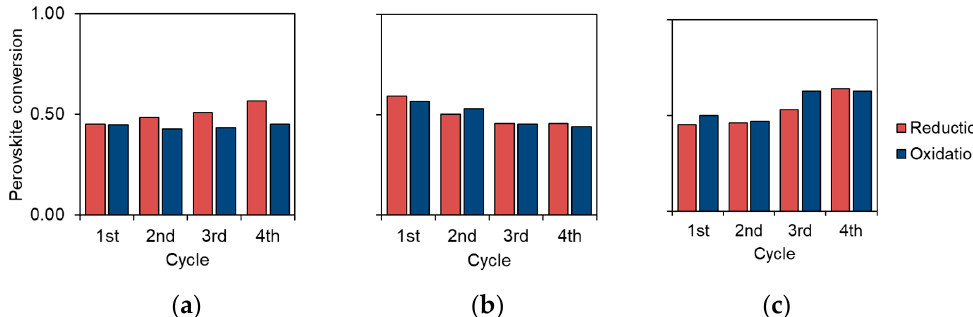
Figure 7. Conversion degree during reduction/oxidation isothermal cycles at ( a ) 860 °C, ( b ) 920 °C, ( c ) 1000 °C.